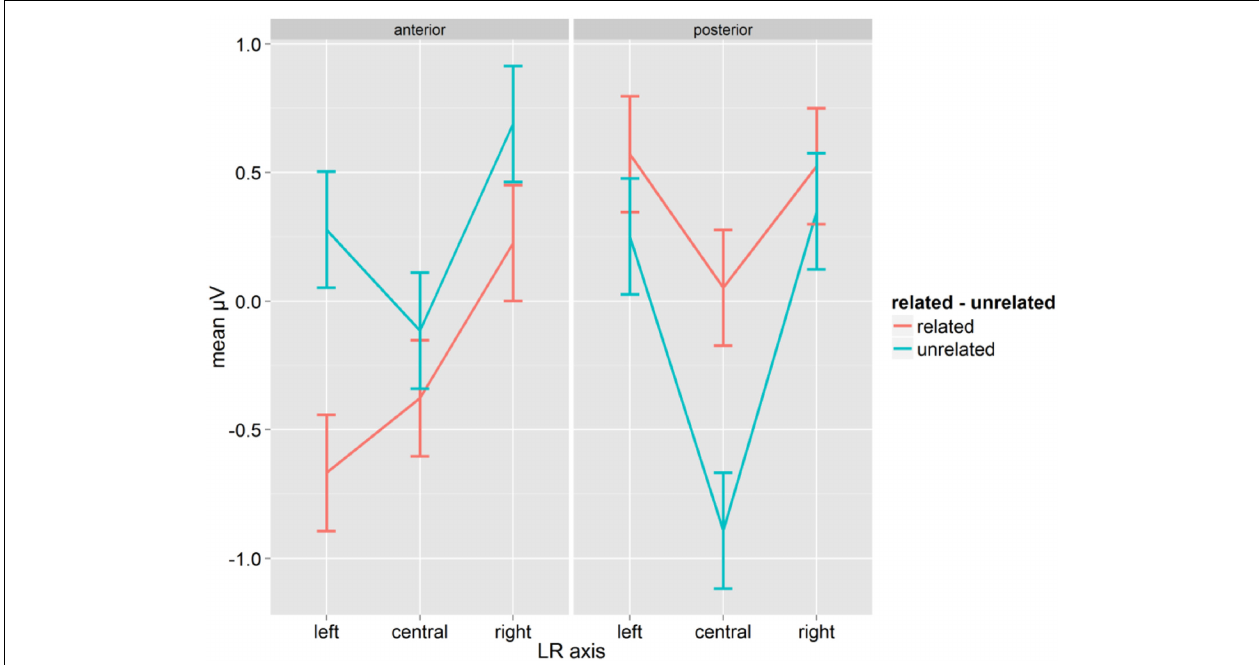
FIGURE 4 | Mean µ V for words as a function of conditions for the time-window 300–400ms; error bars represent Fisher’s least significant differences.